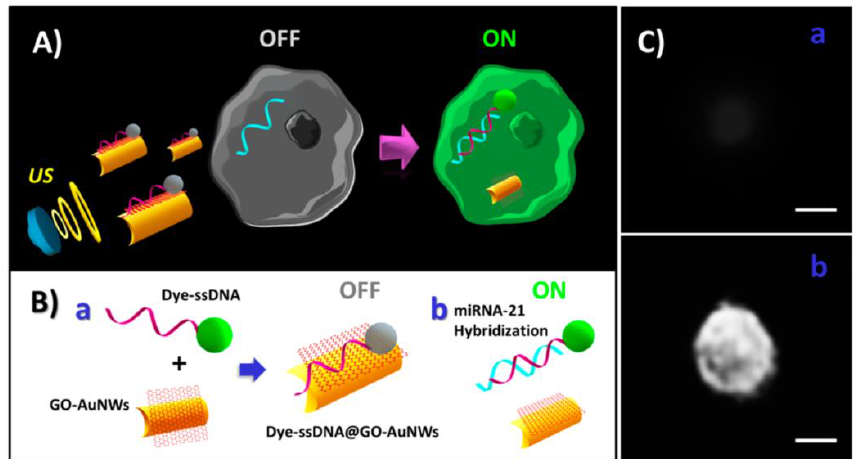
Figure 13. Schematic showing the ultrasound-propelled nanomotor developed for intracellular detection of microRNA and the fluorescence detection of a single cell before and after the nanomotor interaction. Adapted with permission from [413] Copyright 2015 American Chemical Society. with the dye-labelled ssDNA/graphene oxide composite ( a ) and fluorescence recovery after miRNA hybridization ( b ). ( C ) Fluorescence images of a single cell before ( a ) and after ( b ) incubation with the nanomotor. Adapted with permission from [413] Copyright 2015 American Chemical